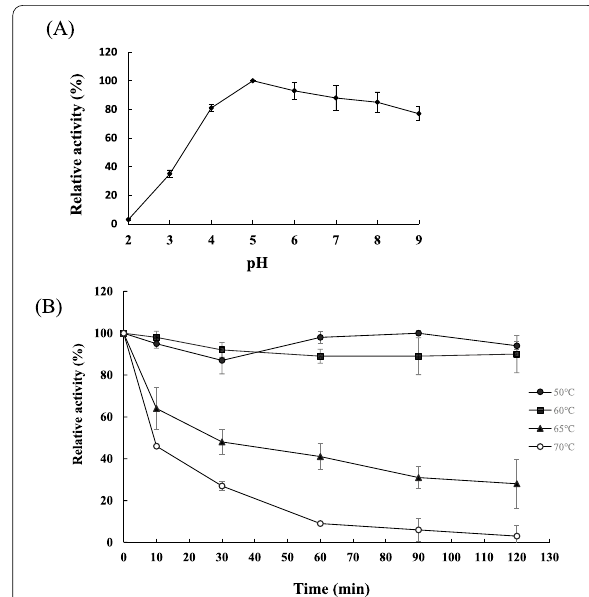
Fig. 4 pH and thermal stability of TvmNAG2. A For pH stability, TvmNAG2 was in 10 mM phosphate buffer at various pH values for 1 h, followed by activity assay. B For thermal stability, TvmNAG2 was incubated at various temperatures (50–70 °C) for 0–120 min, followed by activity assay. The activity assay was performed at 65 °C and pH